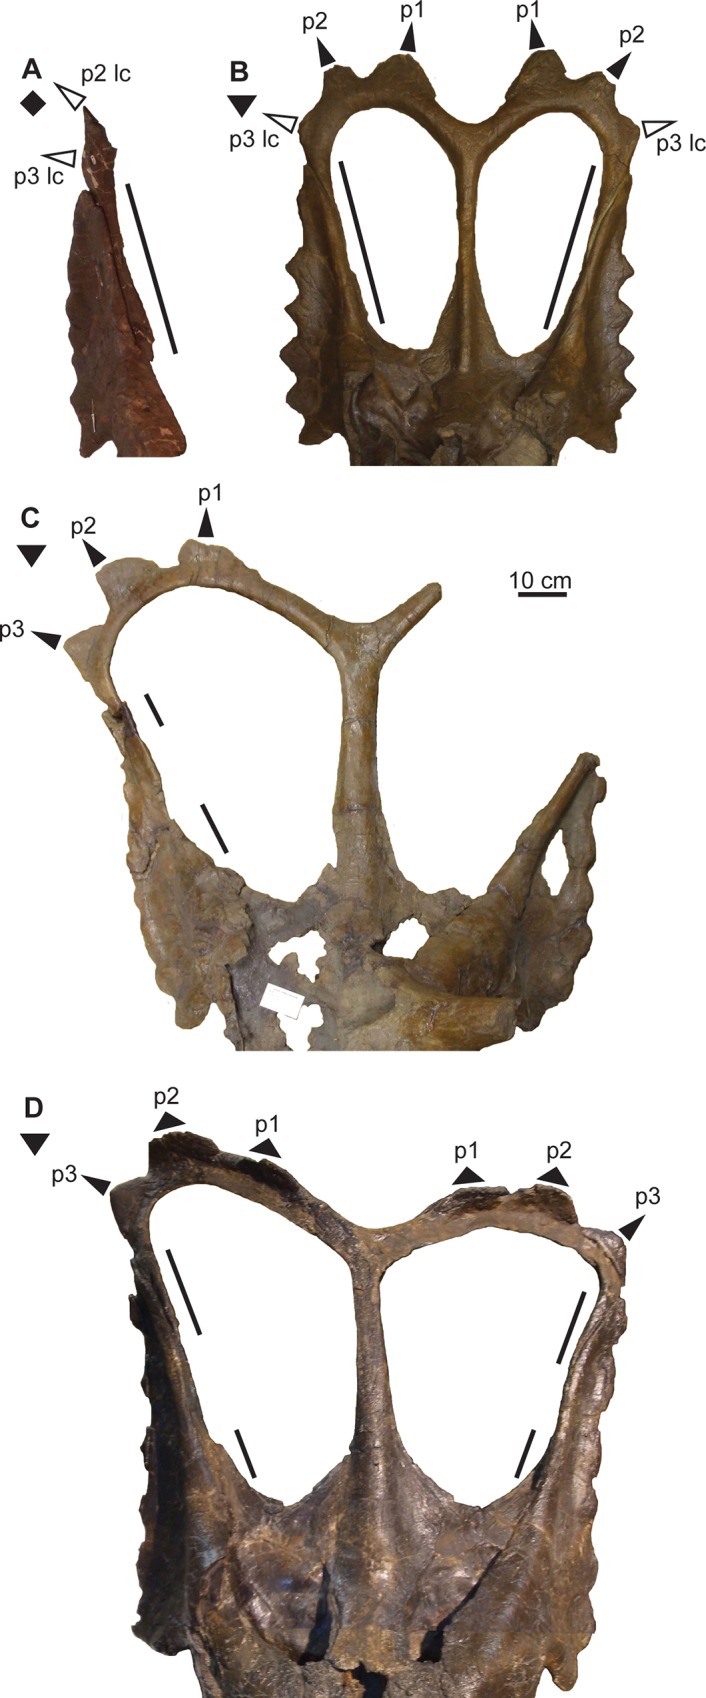
Ontogenetic changes in parietal of Chasmosaurus.Thinning of lateral bar (character 16), articulation (character 17) and reorientation (character 18) of epiparietals (character 18): (A) CMN 1254, (B) AMNH 5656, (C) TMP 1983.025.0001, and (D) CMN 2280 (flipped). Blank triangles = unadorned epiparietal loci; solid triangles = articulated epiparietals; long triangles = epiparietals (or loci) oriented posteriorly in the plane of the frill, and short triangles = epiparietals oriented anterodorsally. Lines represent extent of lateral bars. Chasmosaurus russelli (inverted triangles) and Chasmosaurus sp. (diamond). [planned for column width].